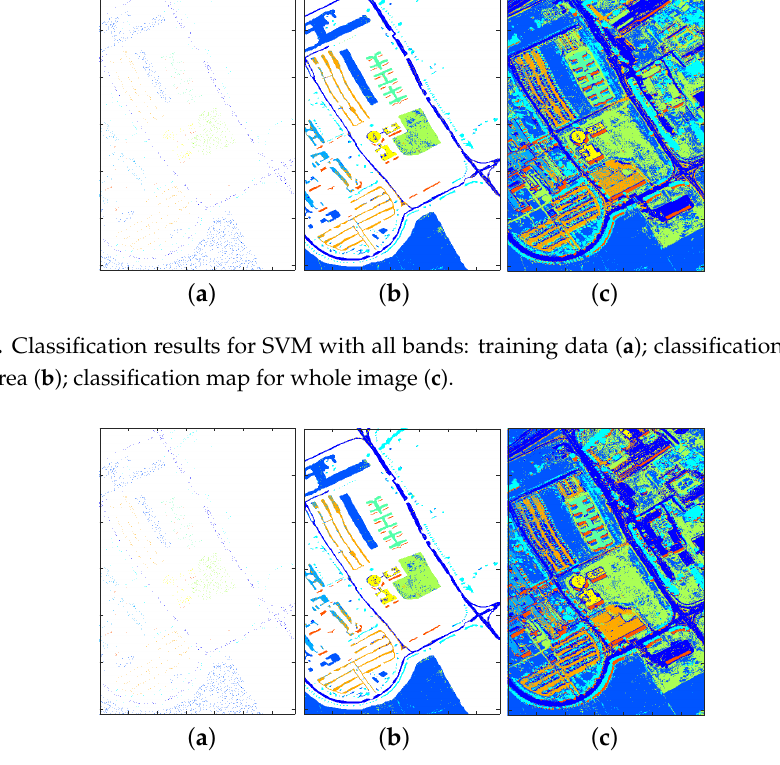
Figure 15. Classification results for SVM with PCA: training data ( a ); classification map for all labelled area ( b ); classification map for whole image ( c